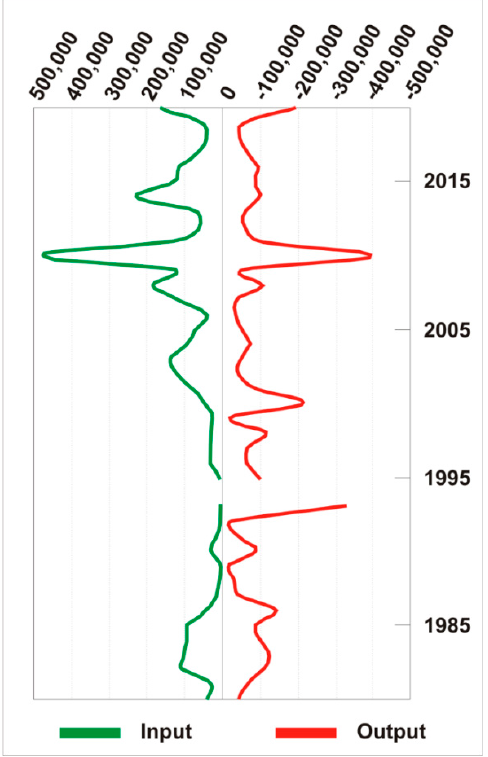
Figure 9. Annual sediment redistribution (expressed in m 3 ) within the Northern Tuscany littoral cell within our timespan. Here, transfers from one sub-cell to another are considered as separate inputs and outputs. Each value has a 3% of uncertainty.